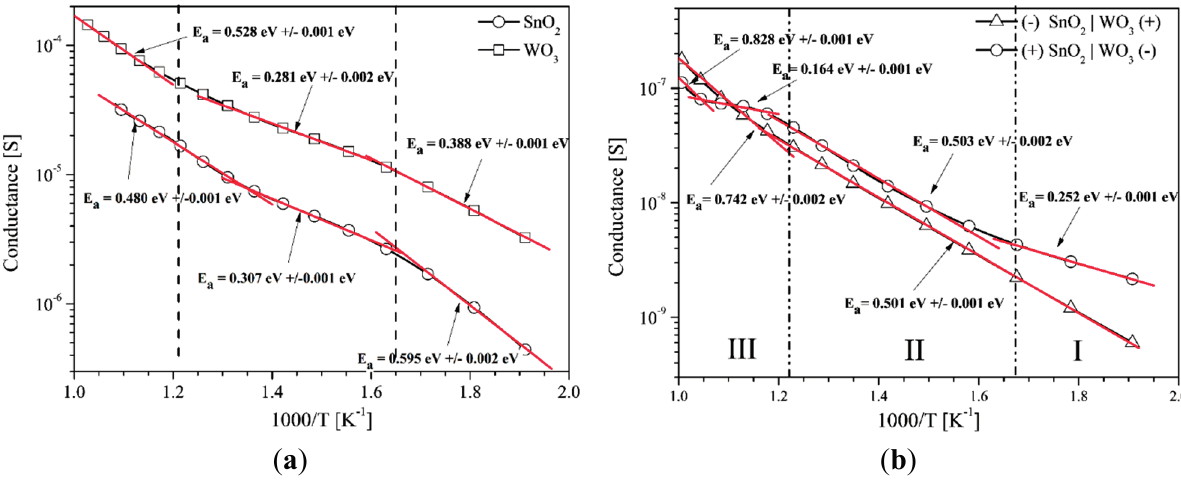
Figure 11. Change in conductance and activation energy of: ( a ) tin dioxide and tungsten trioxide layers; ( b ) SnO 2 |WO 3 heterocontact in function of the inverse of temperature in synthetic air. The reverse direction: (+)WO 3 |SnO 2 ( − ); the forward direction: ( − )WO 3 |SnO 2